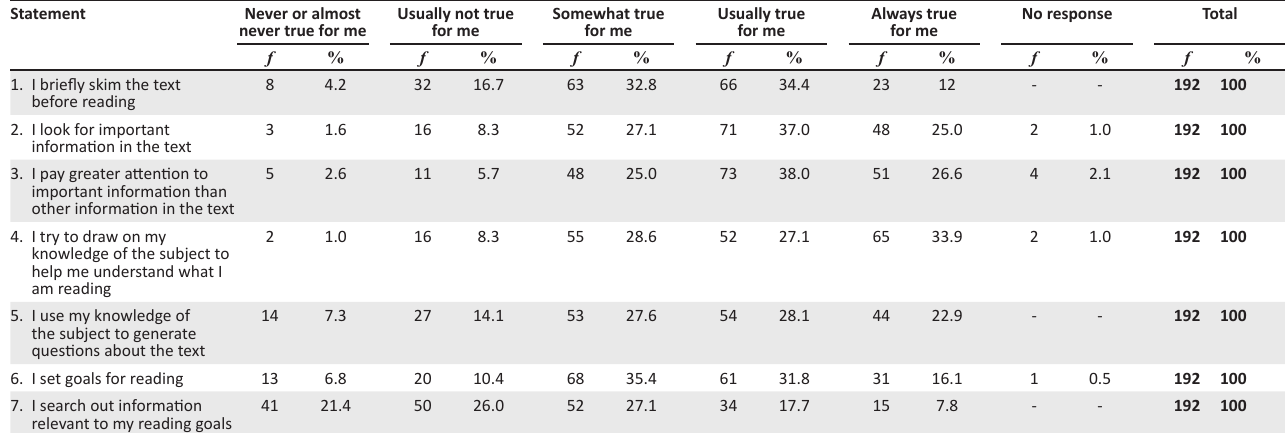
TABLE 1: Pre-reading strategies.